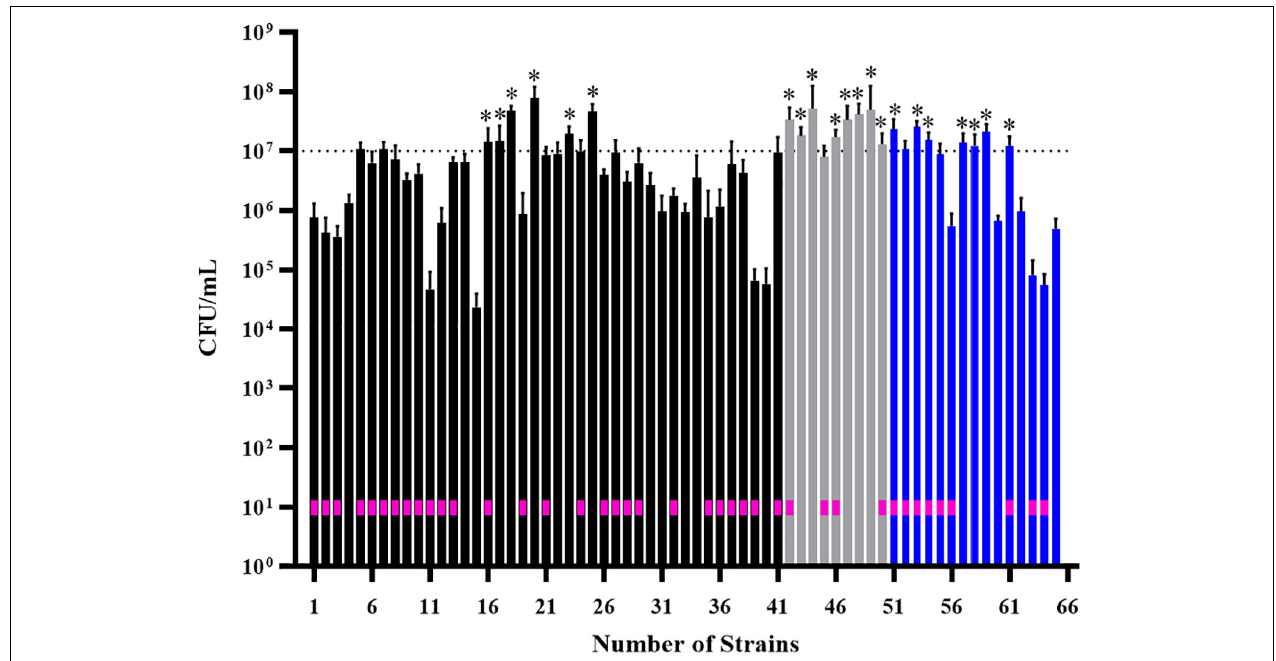
FIGURE 3 | Screening of 55 biofilm-positive E. coli isolates for their ability to form biofilms on polystyrene pegs. After growth for 24 h at 37 ◦ C in BHI (black bars), M63 (gray bars) or 1 / 2 TSB (blue bars) media, cells were dislodged and enumerated from each peg ( n = 6); histogram bars represent the average CFU/mL values and error bars represent the standard deviations. Some isolates formed strong biofilms in more than one media, which is why 65 bars are shown on the graph. Stars above the bars denote the isolates with cell densities greater than 10 7 CFU/mL; these were considered the strongest biofilm forming isolates ( n = 21). The E. coli strains isolated from diseased birds are designated by a pink box within the corresponding histogram